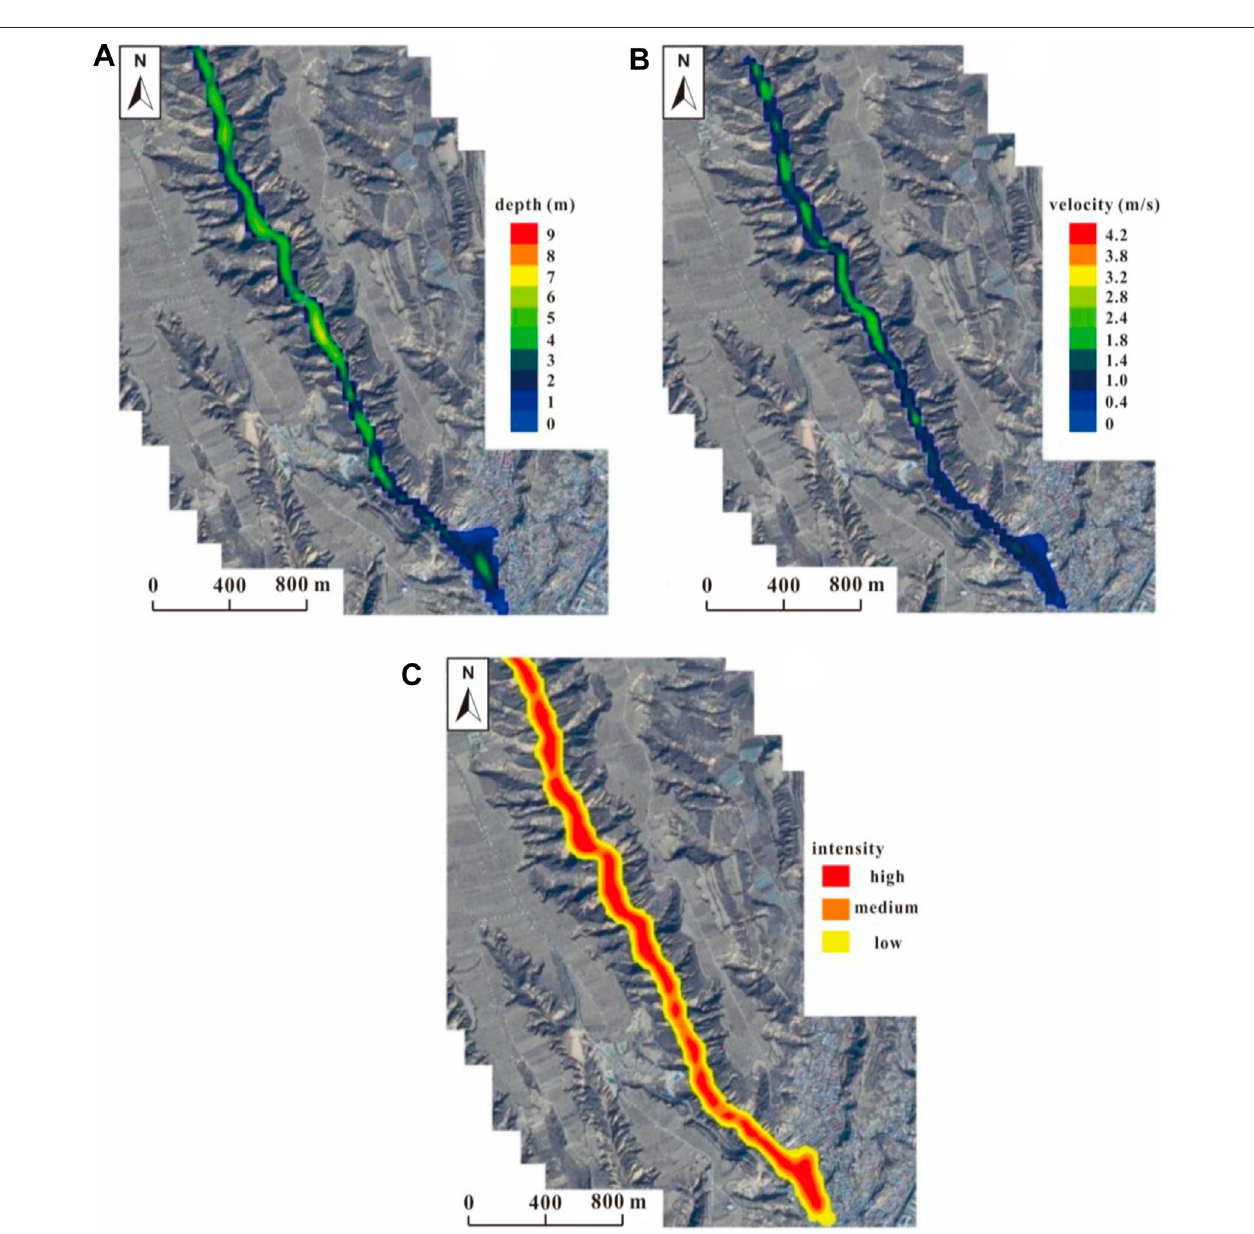
FIGURE 10 | Hazard map of the Chengbei Gully debris fl ow: (A) fl ow depth map and (B) fl ow velocity map calculated from FLO-2D and (C) hazard intensity map.